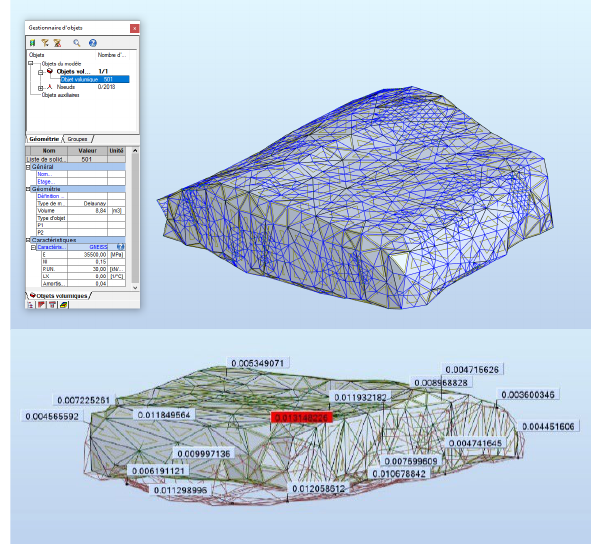
Figure 11. Ceiling stone of the chamber in the FEM software (top) and its deformation in mm after simulation